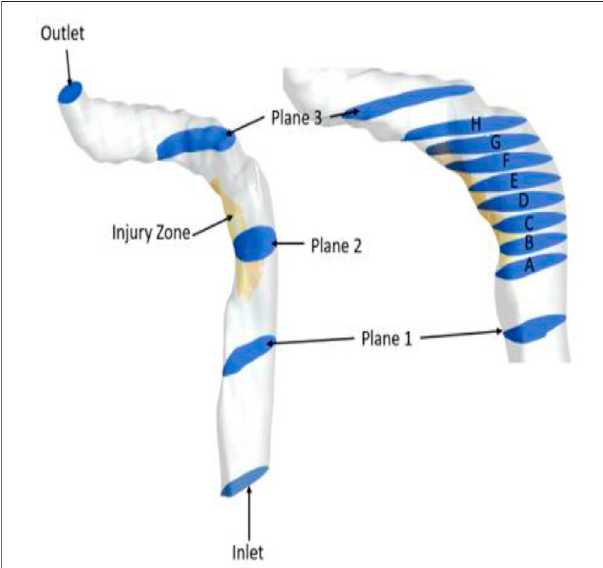
FIGURE 13 | Planes of interest used for result analysis. Planes 1, 2, and 3areused tostudythemechanicalpropertiesandplanes A – Harefocused on studying clot formation (patient-speci fi c model).